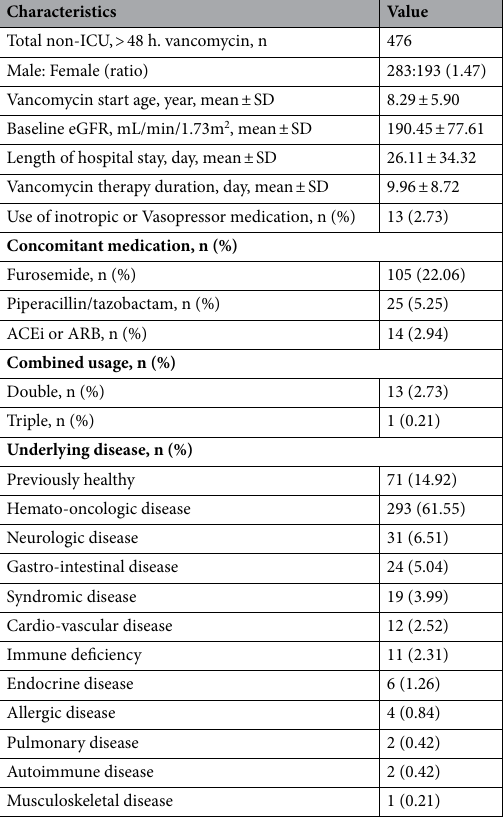
Table 1. Patient demographic and clinical data. ICU intensive care unit, SD standard deviation, eGFR estimated glomerular filtration rate, ACEi angiotensin converting enzyme inhibitors, ARB angiotensin II receptor